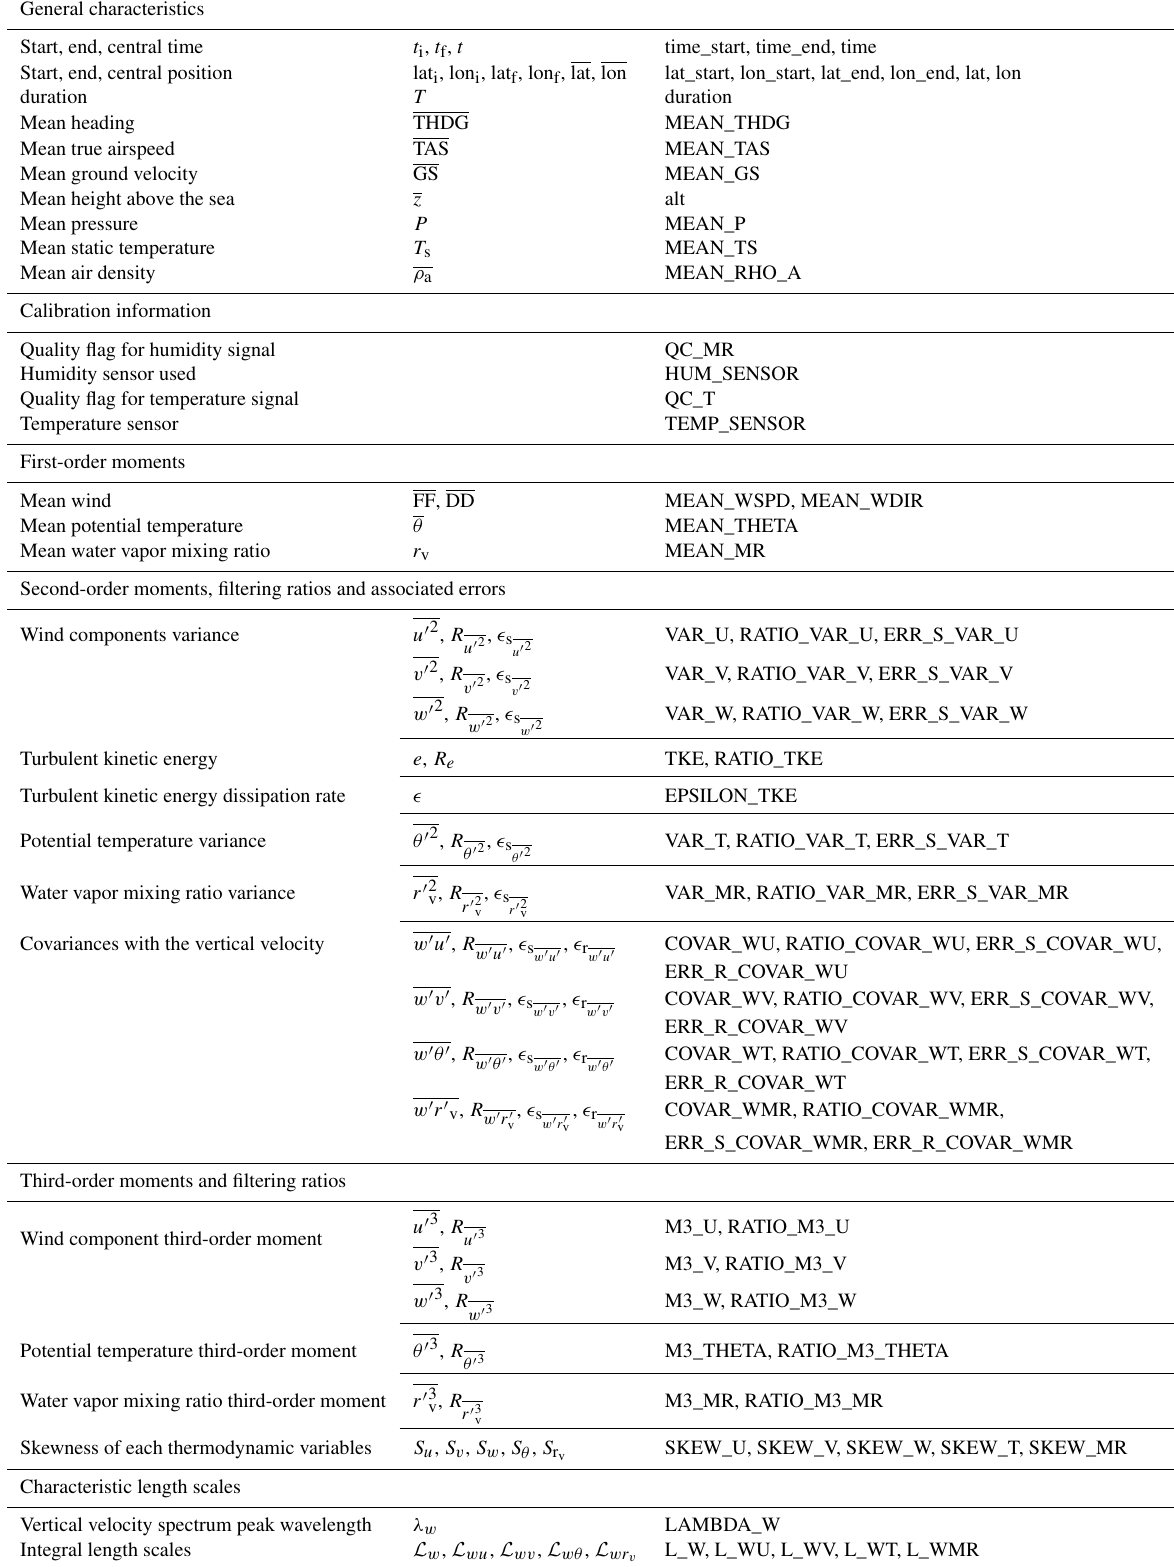
Table 2. List of turbulent parameters calculated over each segment, their standard nomenclature and their names in the NetCDF files. General